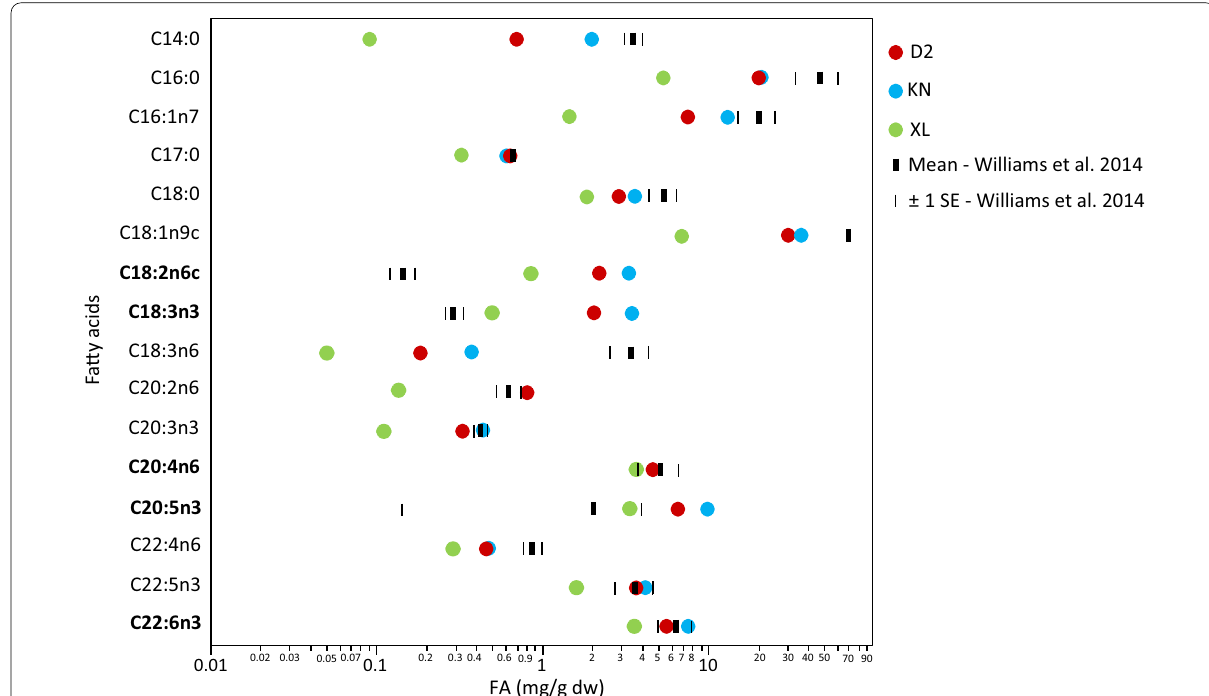
Fig. 11 Mean fatty acid concentration (FA mg/g dw) in anterior dorsal muscle tissue of lake sturgeon ( n tailwaters below Lock and Dam 2 (D2, red circle) of the Mississippi River, Kinnickinnic narrows (KN, blue circle) and near the Xcel Energy Plant (XL, green circle), both in the St. Croix River. The fatty acid concentration (converted to mg/g dw) of lake sturgeon (fillets, n Menominee River are provided for comparison (black squares include: LIN (C18:2n6c), ALA (C18:3n3), ARA (C20:4n6), EPA (C20:5n3), and DHA (C22:6n3). All fatty acid data presented in this figure are published in Zigler et al.